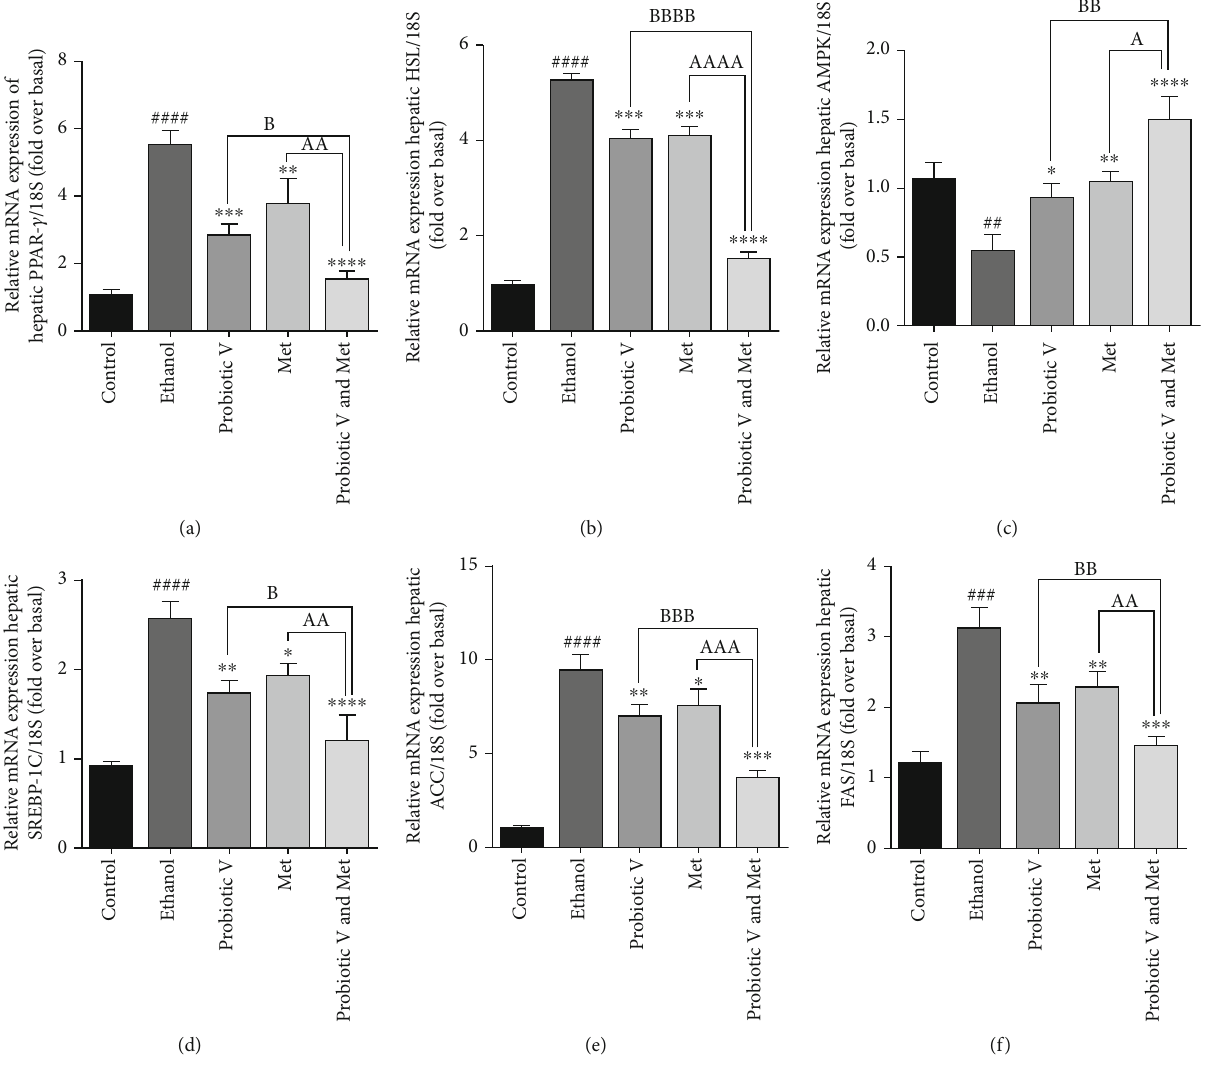
Figure 9: E ff ect of probiotic V and Met alone or in combination regulates the lipid metabolism in ethanol-induced hepatic injury. Hepatic levels of lipogenic markers, i.e., (a) PPAR- γ , (b) HSL, (c) AMPK, (d) SREBP-1c, (e) ACC, and (f) FAS. Values are expressed as mean ± SD of six rats. Statistical signi fi cance was assessed by one-way ANOVA followed by Tukey post hoc test. Statistical analysis: ## p < 0 : 01 , ### p < 0 : 001 , and #### p < 0 : 0001 compared with control group; ∗ p < 0 : 05 , ∗∗ p < 0 : 01 , ∗∗∗ p < 0 : 0001 , and ∗∗∗∗ p < 0 : 0001 compared with ethanol group; A,B p < 0 : 05 , AA,BB p < 0 : 01 , AAA,BBB p < 0 : 001 , and AAAA,BBBB p < 0 : 0001 compared with probiotic V and Met combinatorial group. PPAR- γ : proliferator-activated receptor-gamma; HSL: hormone sensitive lipase; AMPK: adenosine monophosphate-activated protein kinase; SREBP-1c: sterol regulatory element binding protein 1c; ACC: acetyl-CoA carboxylase; FAS: fatty acid